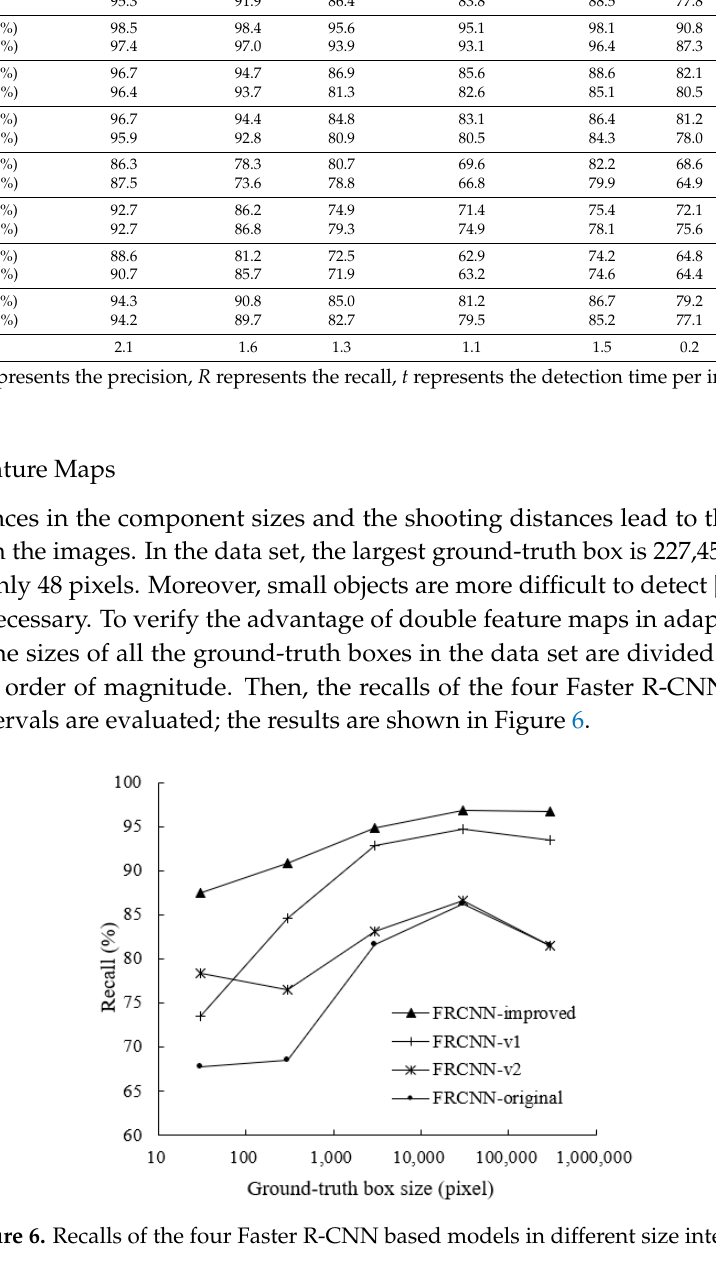
( b ) Figure 7. Detection results of two test images. The categories and probabilities are not displayed for brevity. ( a ) A relatively frontal shooting angle; ( b ) A lateral shooting angle. 5.2.2. Relative Position Features In the proposal generation module, with the relative position features between proposals and final boxes, the RF classifier can refine the proposal probabilities of containing an object or not containing an object (e.g., decrease the probability of containing an object if a proposal is far from the final boxes), while the RF regressor can refine the proposal coordinates by learning the proportion relations of the component sizes and positions. The detection process of FRCNN ‐ improved is used to illustrate the advantage of relative position features. In the detection process of an image, as the number of iterations increases, more final boxes will be generated and thus more relative position features are available for proposal generation. Because a test image